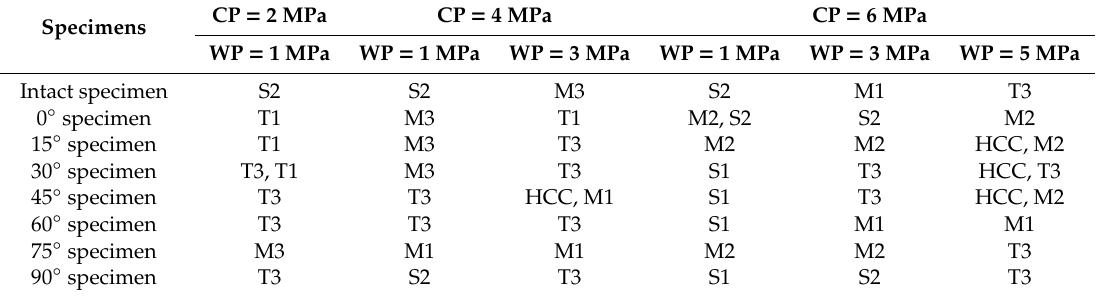
Table 3. Summary of all crack types observed in hydraulic coupled triaxial test.